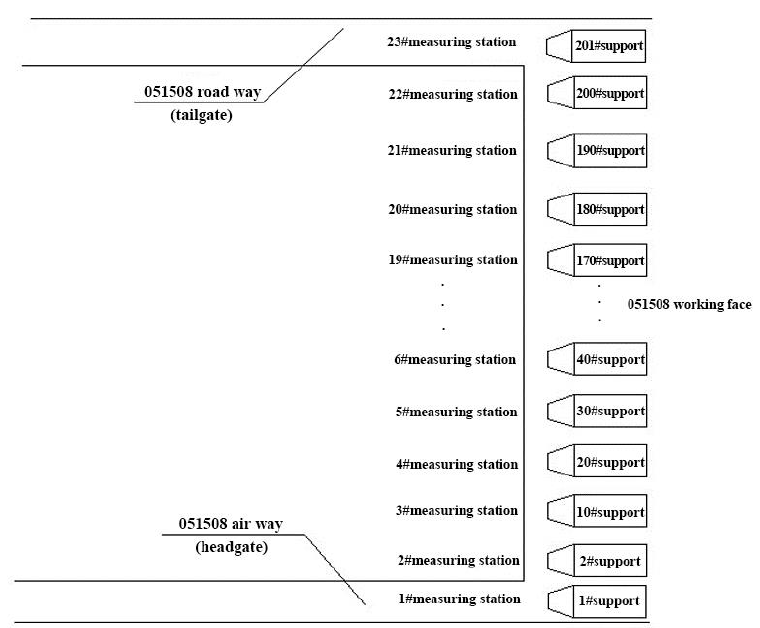
Figure 9. Schematic diagram of the monitoring system for support resistance.